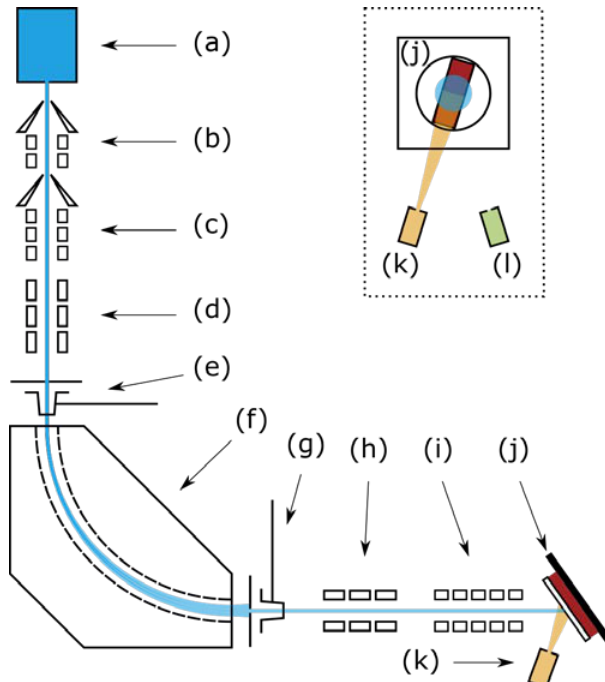
Figure 1. Sketch of the cluster ion beam deposition system. ( a ) Haberland-type inert-gas-condensation cluster-beam source, ( b ) 1st skimmer and acceleration lens set, ( c ) 2nd skimmer and acceleration lens set, ( d ) 1st quadrupole triplet, ( e ) 1st slit and Faraday cup, ( f ) 90° sector magnet, ( g ) 2nd slit and Faraday cup, ( h ) 2nd quadrupole triplet, ( i ) deceleration lens set and, ( j ) sample, ( k ) effusion cell and ( l ) triple electron beam evaporator. A third Faraday cup can be moved into the beam at the sample’s position (not shown). As indicated in the main sketch, effusion cell and triple e-beam evaporator are tilted by 70° to the horizontal cluster ion beam axis in vertical direction. As a compromise, the sample is set to an angle of 35° with respect to each incident beam. The inset depicts the ±17° tilt of the effusion cell and triple e-beam evaporator from the vertical direction. The slit mask (white) covering the sample chip (red) and its orientation is depicted there.